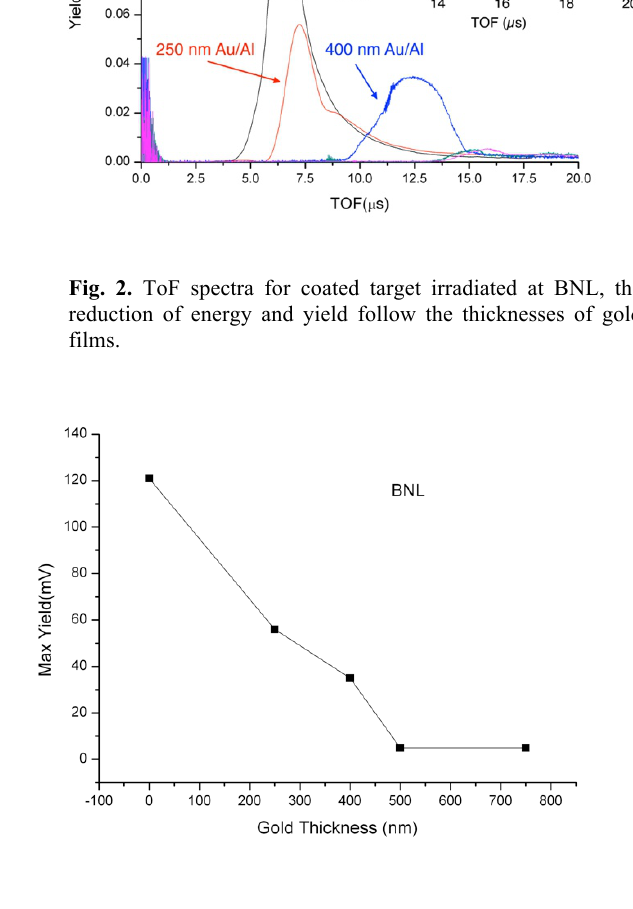
Fig. 3. Measured plasma yield with FC.